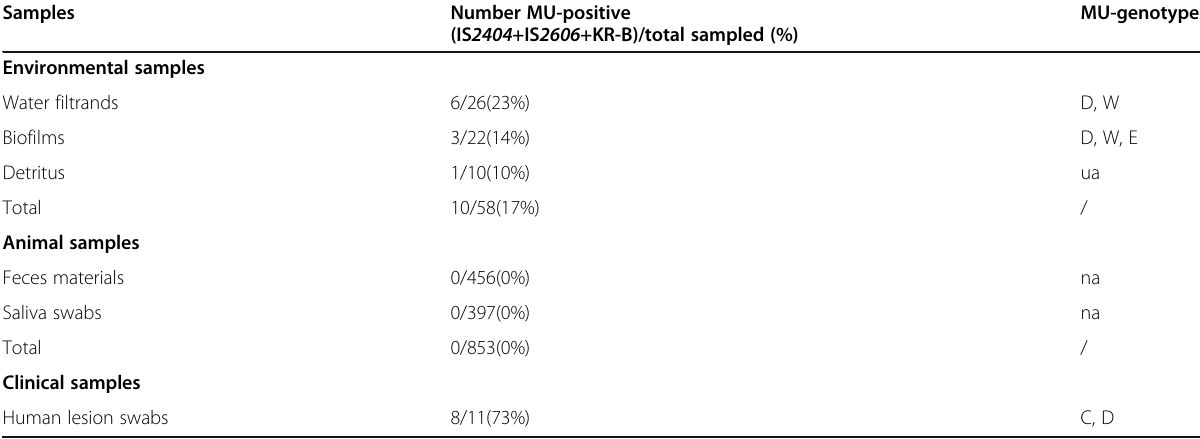
Table 1 Distribution of environmental and human samples tested and percentage positive for MU